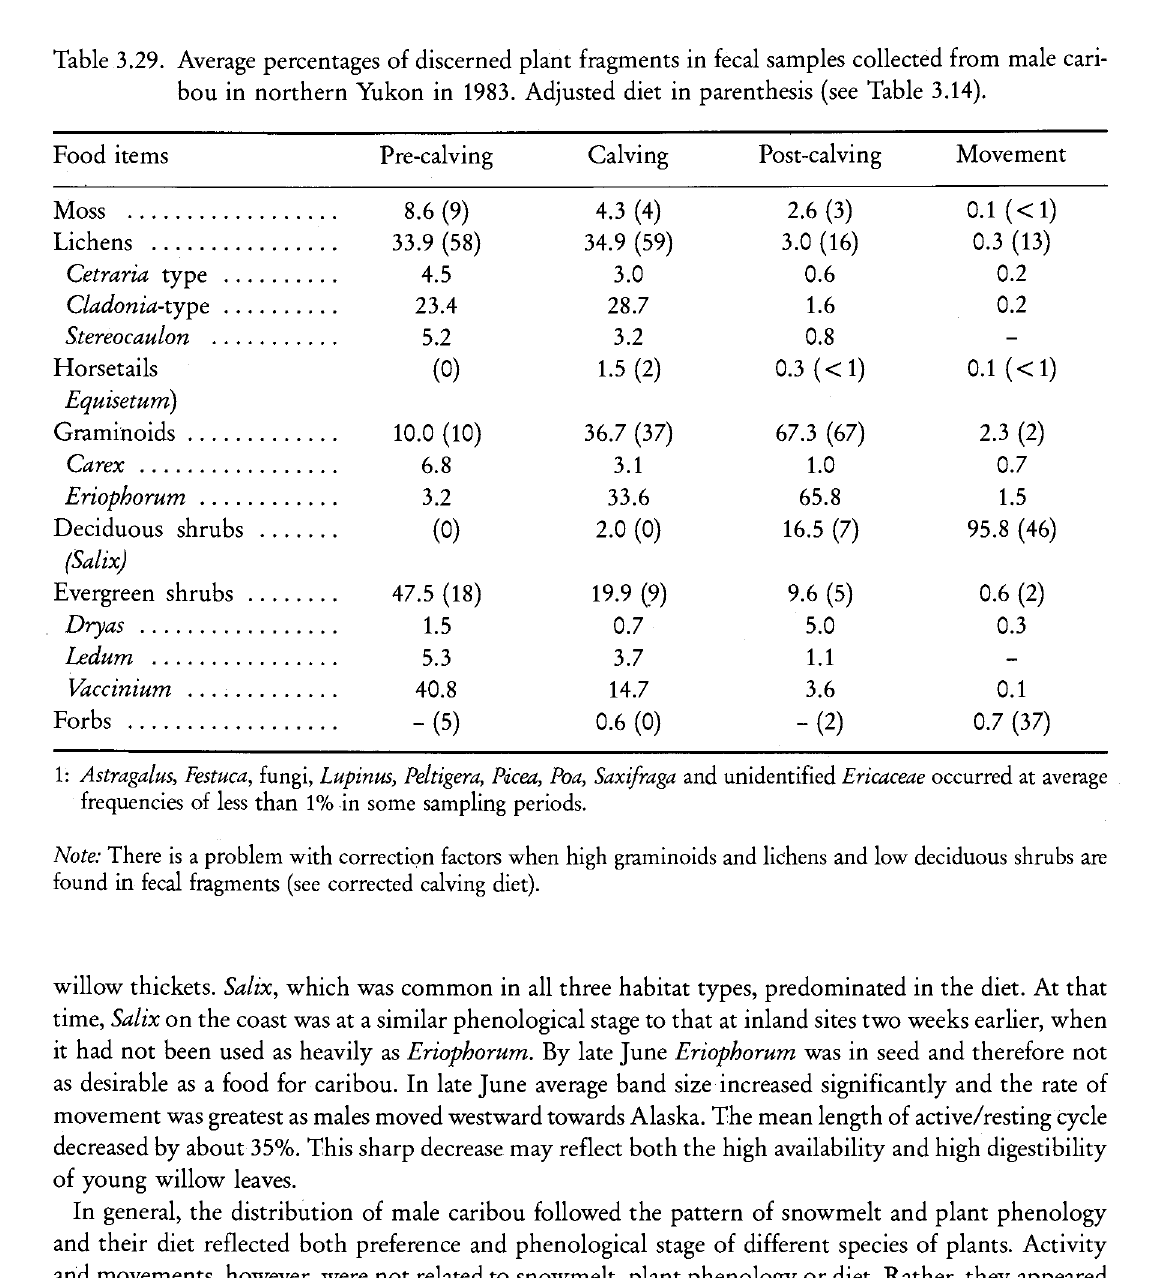
Table 3.29. Average percentages of discerned plant fragments in fecal samples collected from male cari bou in northern Yukon in 1983. Adjusted diet in parenthesis (see Table